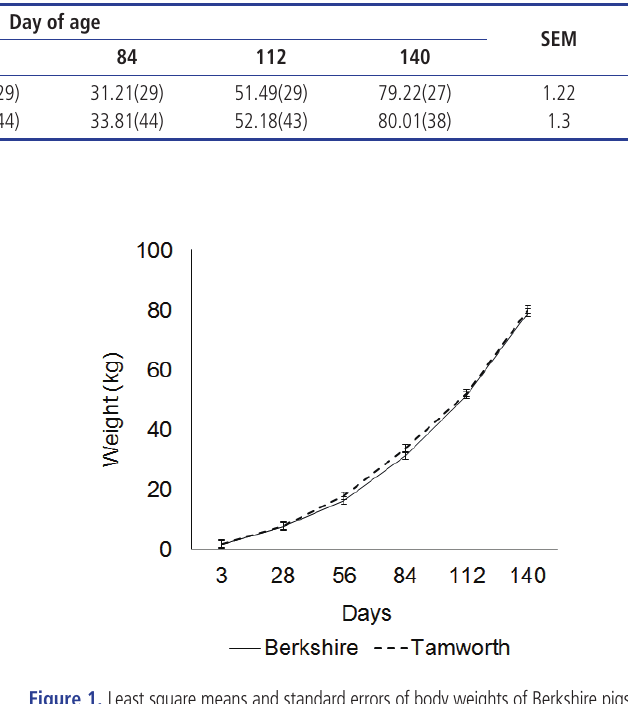
Table 3. Least square means of body weights of Berkshire pigs sired by Berkshire and Tamworth 1)